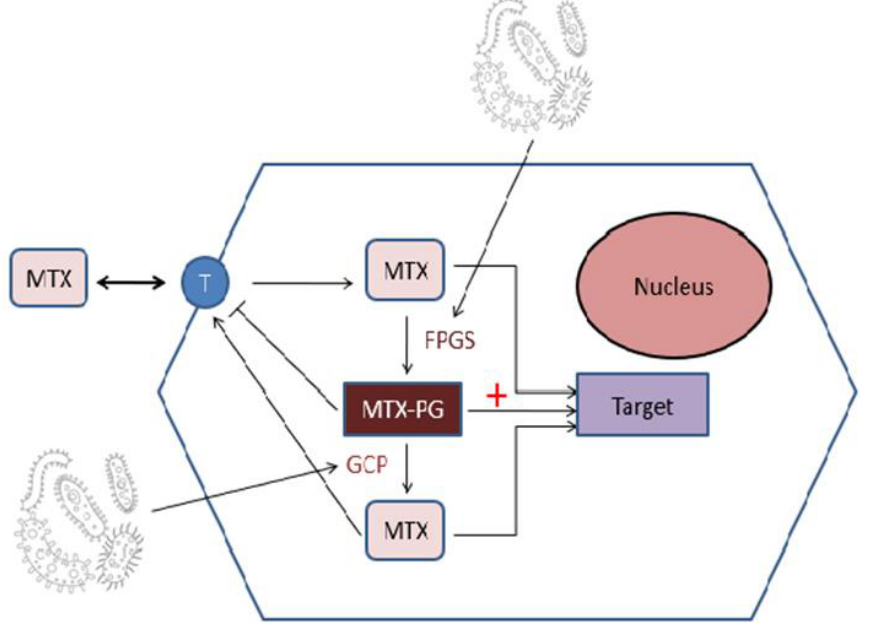
Figure 2. Once into cell, MTX is polyglutamated to MTX-PG by the enzyme folylpolyglutamate syn- thase (FPGS). This compound gains more affinity for the drug target, but it loses affinity for MTX- Transporter (T) hindering the release from the cell. Another enzyme, named glutamate carboxypep- tidase (GCP), removes glutamate from MTX-PG permitting the transportation out of the cell. FPGS and GCP are enzymes expressed by many gut bacteria, suggesting a potential role in the efficacy of MTX .